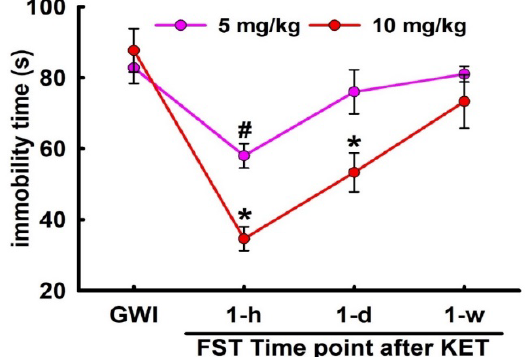
Figure 5. Sustained e ff ect of KET on the FST behavior in a DFP rat model for GWI. GWI rats were treated with e ff ective doses of KET (5 and 10 mg / kg, i.p.) and subjected to FST session at 1 day and 1 week after KET injection. Significant long-lasting decreases in immobility time were observed only with KET (10 mg / kg) at 1 day but not at 1 week (data expressed as mean ± SEM GWI immobility, * p < 0.05, t -test, n = 7 rats / group).